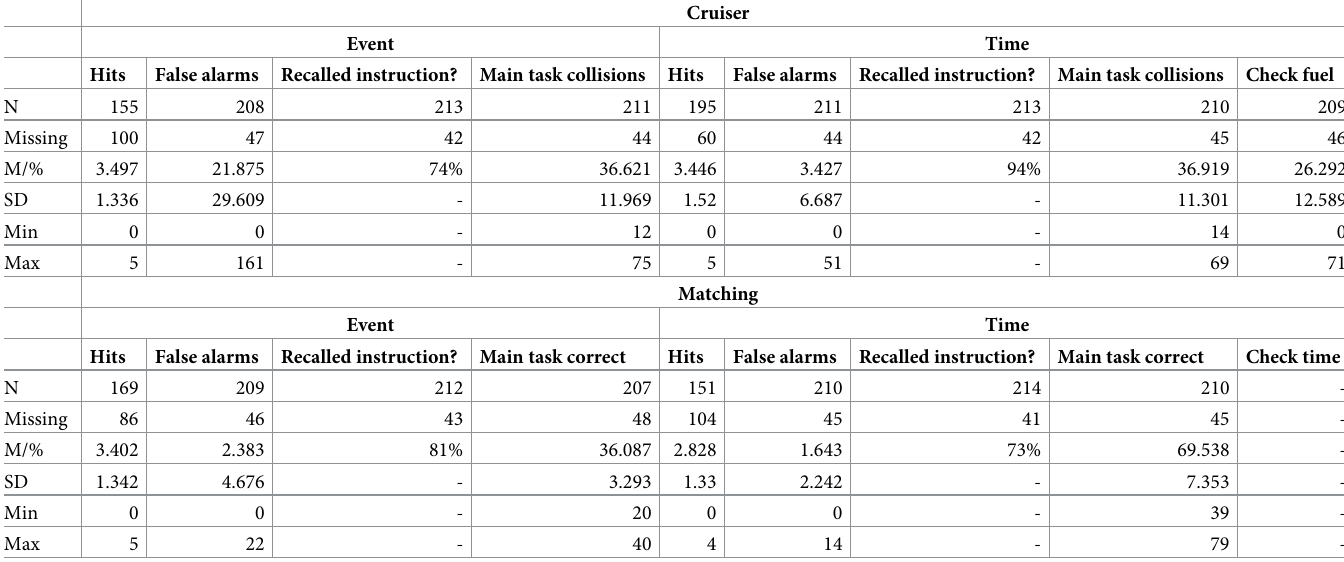
Table 3. Performance on the other PM tasks.